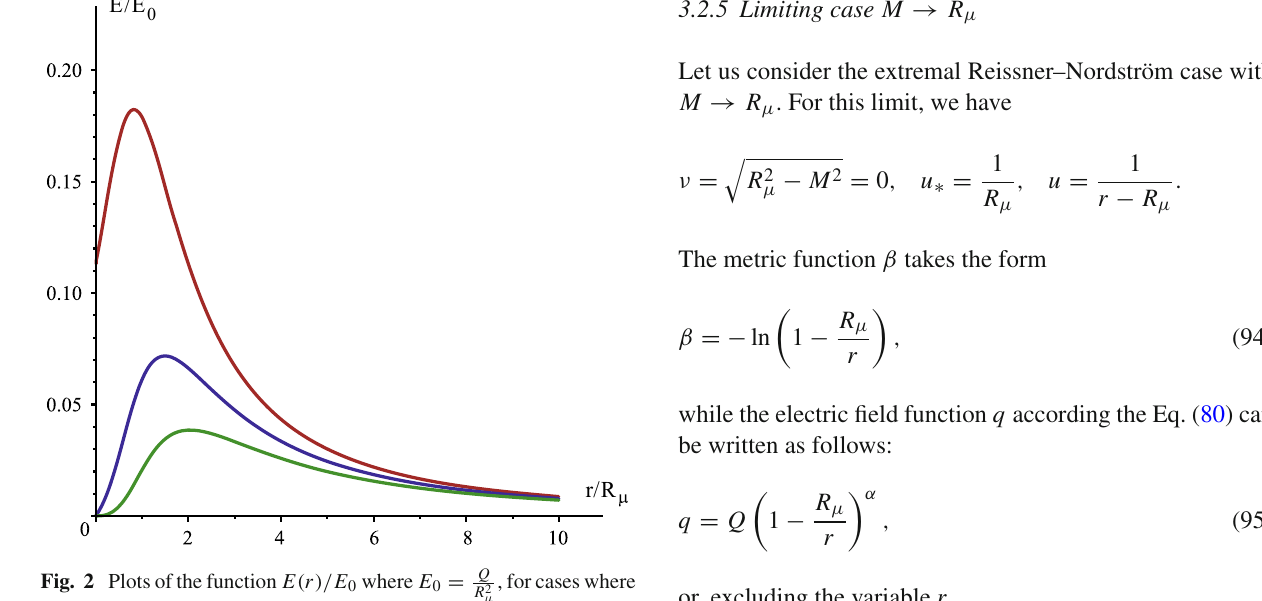
, for cases where R 2 μ